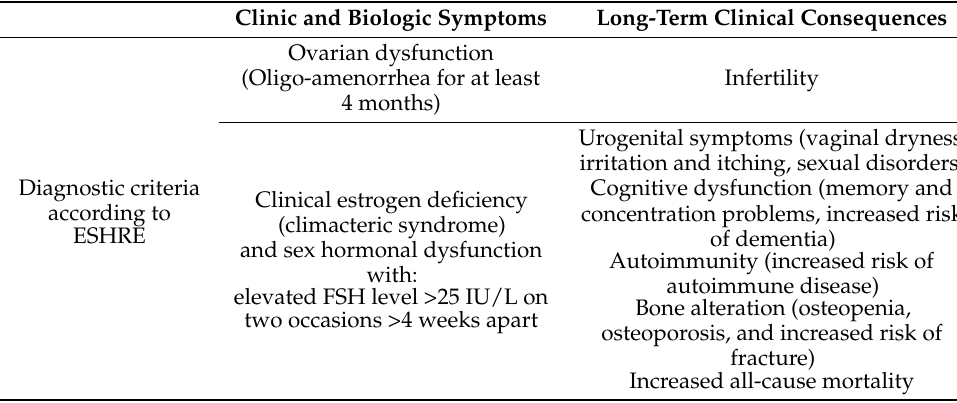
Table 3. POF symptoms and long-term conditions